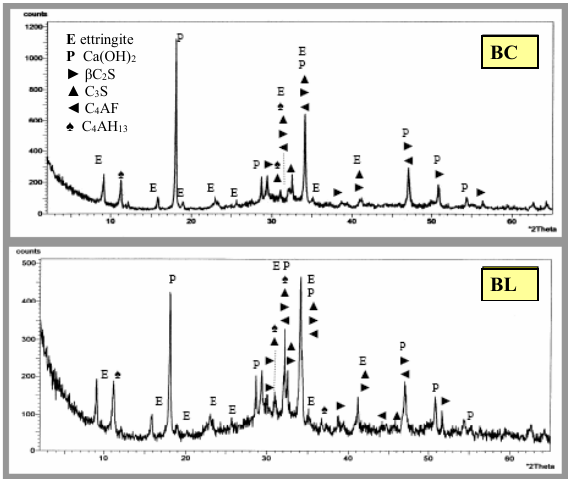
Fig. 8. Radiogram of concrete specimens after 365 days of